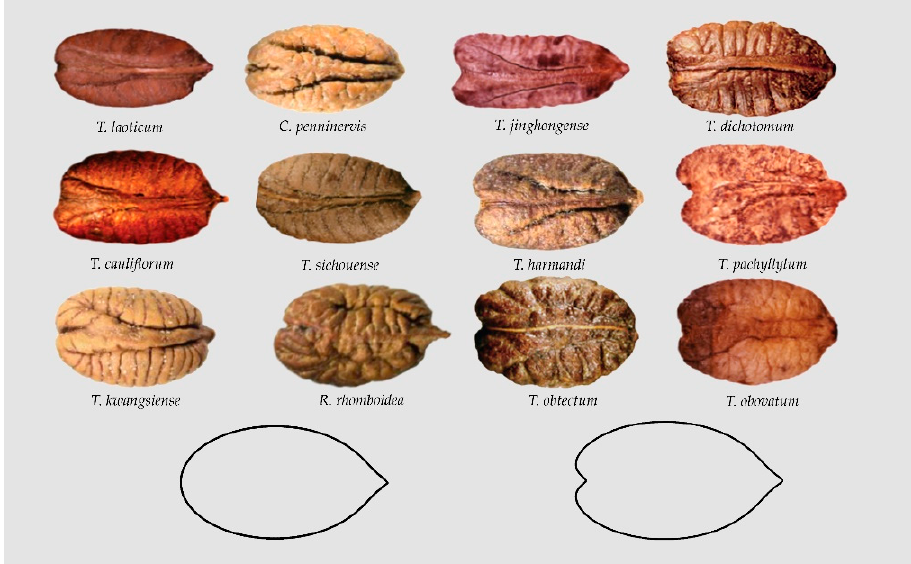
Figure 9. Seeds of Rhoicissus rhomboidea and many species of Tetrastigma resemble polarized ellipses with a side rounded or bi-lobulated and the other acute. with a side rounded or bi-lobulated and the other